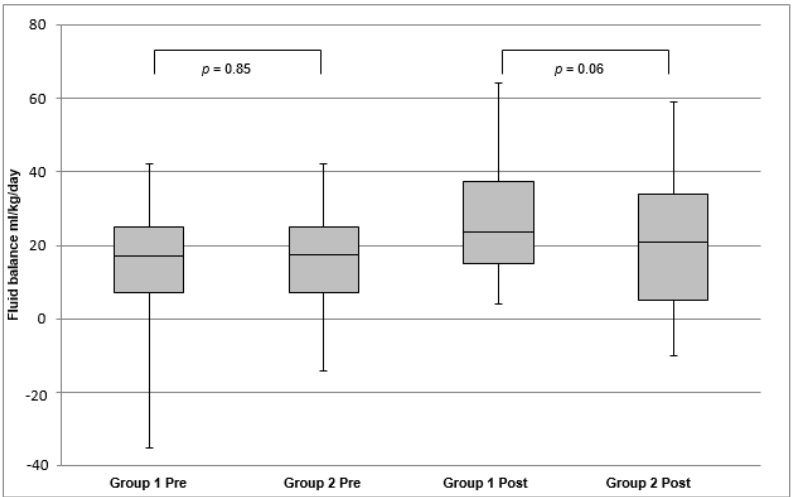
Figure 1. Average daily fluid balance before and after starting NaCl